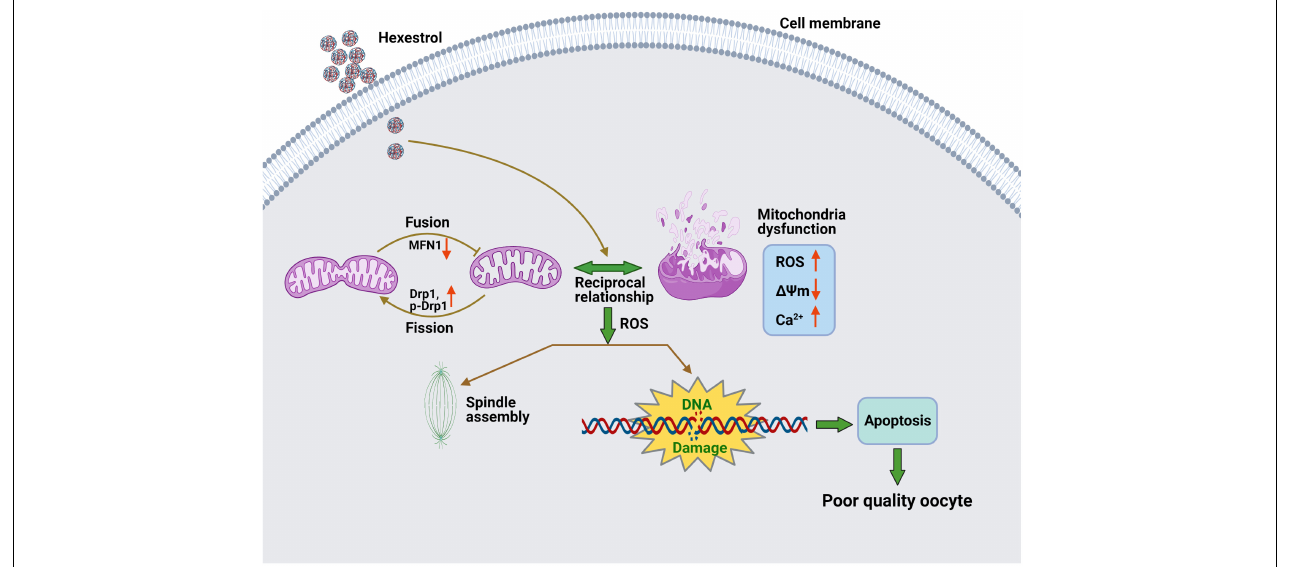
FIGURE 7 | Potential mechanism of abnormal meiotic progress induced by HES